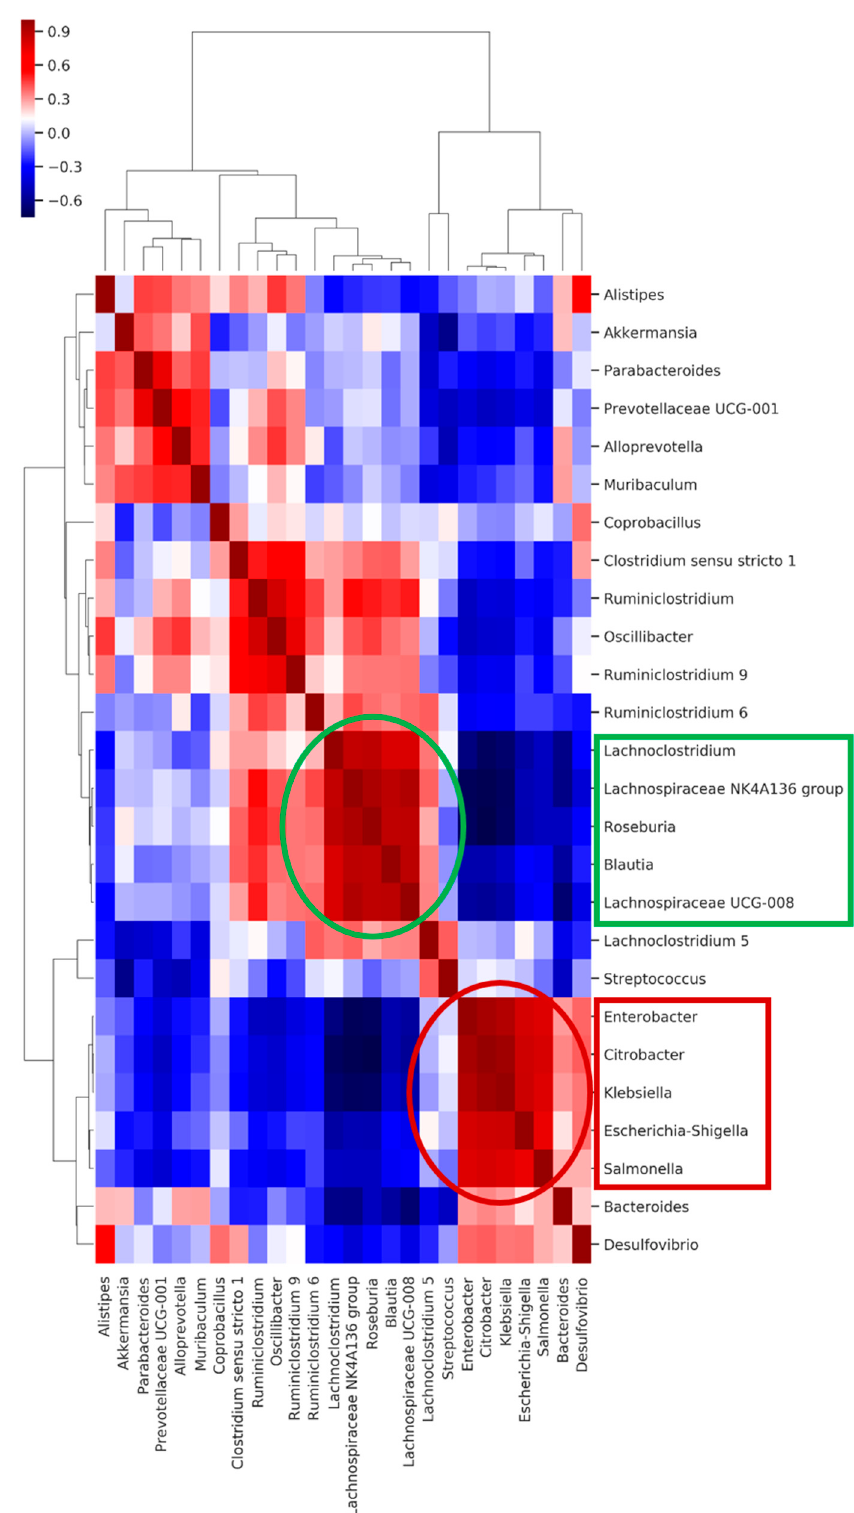
Figure 8. The heatmap shows the pairwise correlation (Spearman’s rho) between selected bacterial abundances in day-15 samples. The bacterial groups at the x- and y-axes were clustered based on Bray–Curtis distances. Colors are corresponding to the rho values: deeper blue colors represent stronger negative, deeper red colors stronger positive correlations.